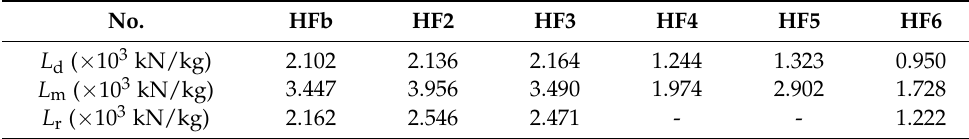
Table 6. The bond loads of per unit weight hooked-end steel fibers.